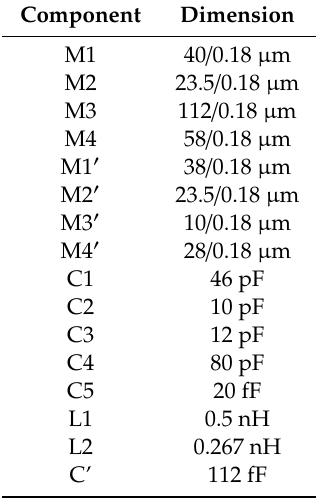
Table 1. The dimensions values of each component in power harvester